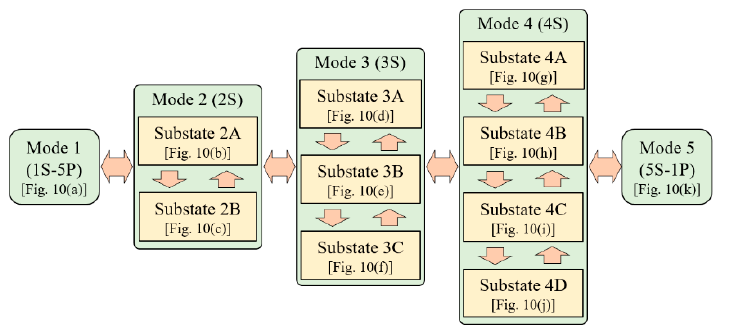
Figure 11. Mode transition map.